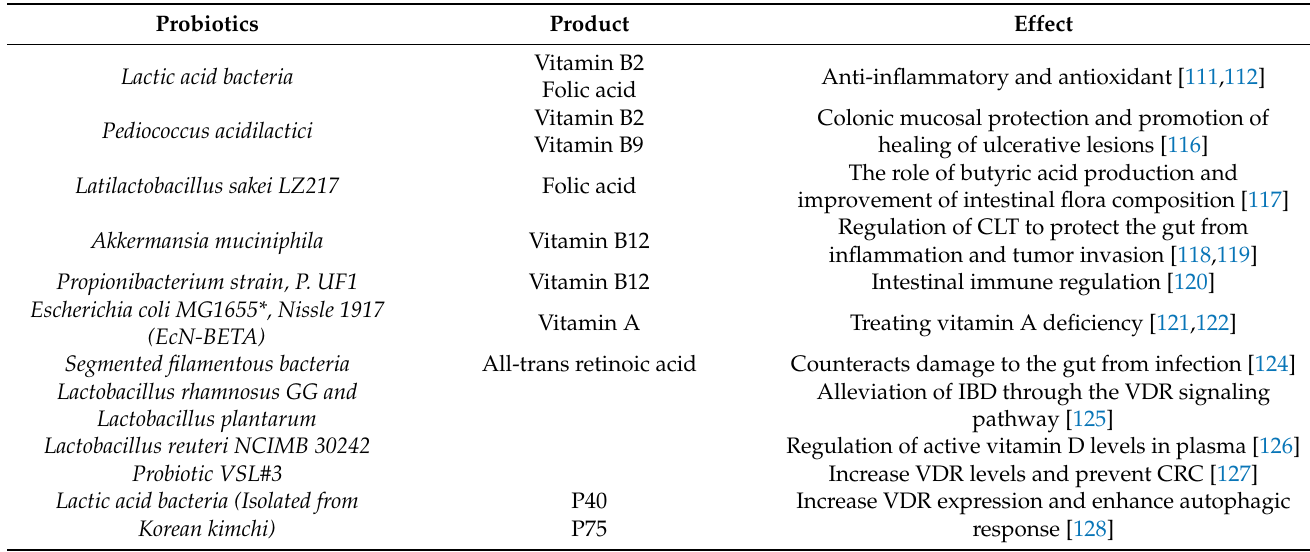
Table 2. The role of vitamin-producing probiotics in intestinal inflammation and carcinogenesis. The table is modified according to: